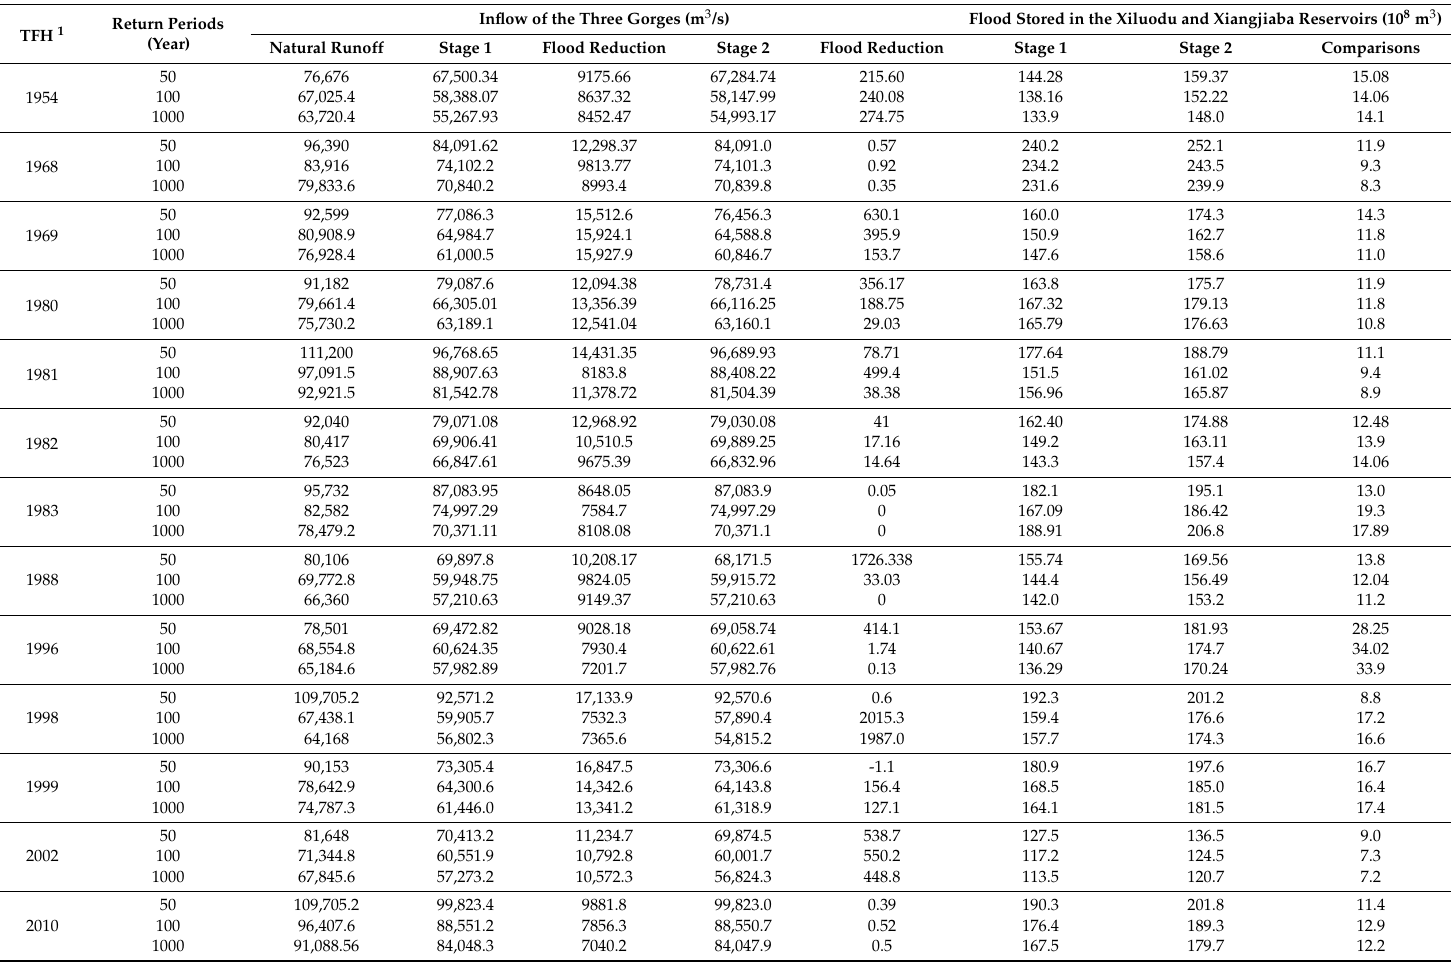
Table 3. Operation results of the Xiluodu–Xiangjiaba cascade